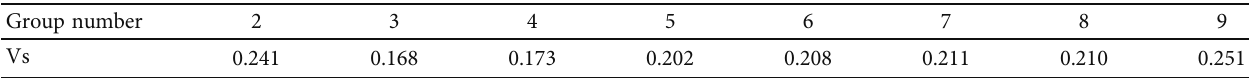
Figure 6: Density contours of structure plane pole. Table 3: Validity test results.